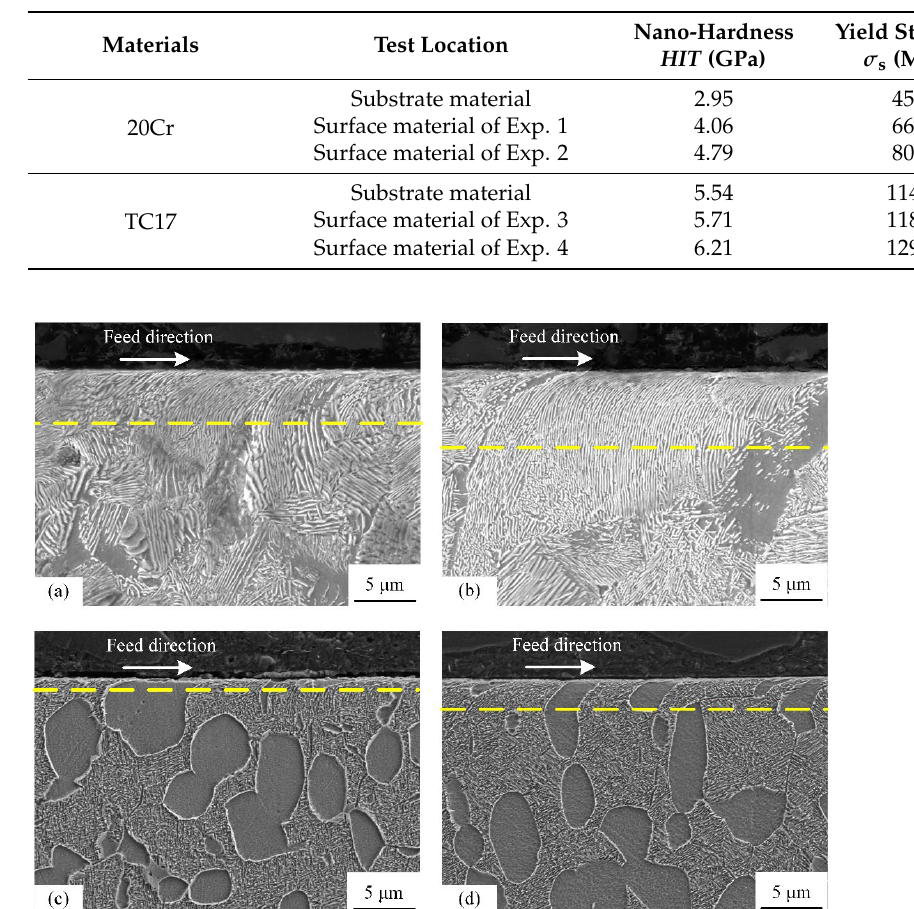
Figure 3. Surface microstructures of 20Cr and TC17: ( a ) Exp. 1, a e = 0.1 mm; ( b ) Exp. 2, a e = 0.7 mm; ( c ) Exp. 3, v s = 80 m/min, a e = 0.2 mm and ( d ) Exp. 4, v s = 30 m/min, a e = 0.7 mm. Table 7. Calculated yield strength of 20Cr and TC17